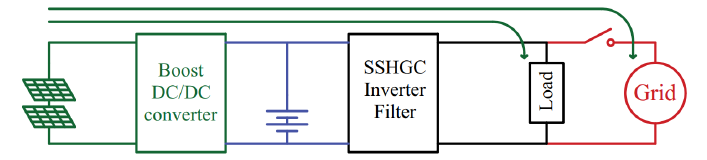
Figure 10. Power operation mode 7.